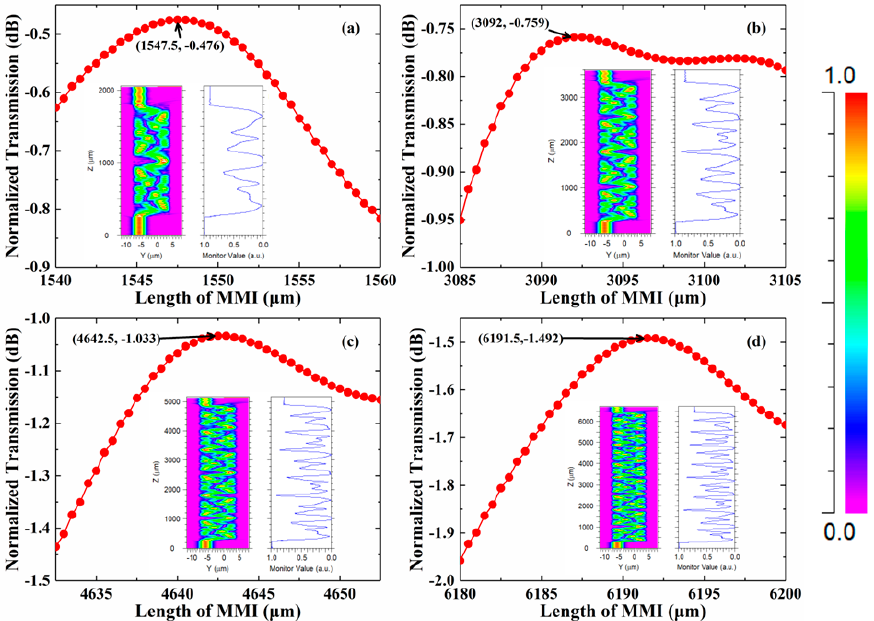
Figure 3. Optimized lengths of MMI that are ( a ) 1-period, ( b ) 2-period, ( c ) 3-period, and ( d ) 4-period. The inserts are light propagation in the MMI.